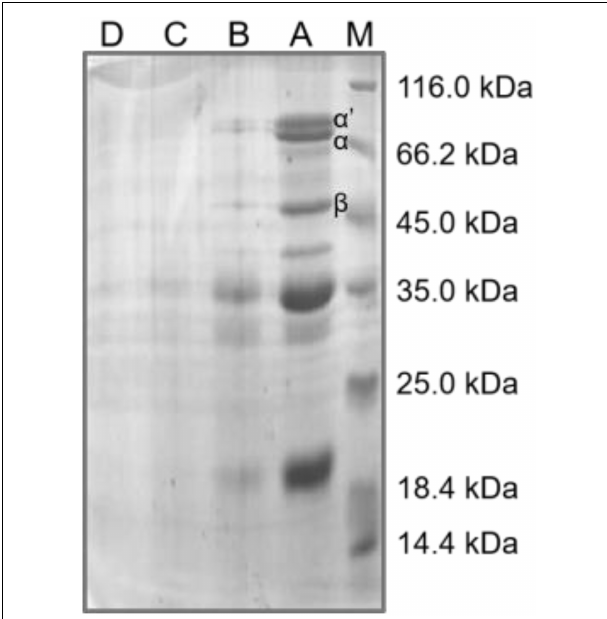
FIGURE 3 | The sodium dodecyl sulfate-polyacrylamide gel electrophoresis (SDS-PAGE) profile of soybean meal protein. M, standard protein markers; A, native soybean meal; B, C, and D indicated soybean meal treated by steam explosion at 0.3, 0.5, and 0.7 MPa, respectively.